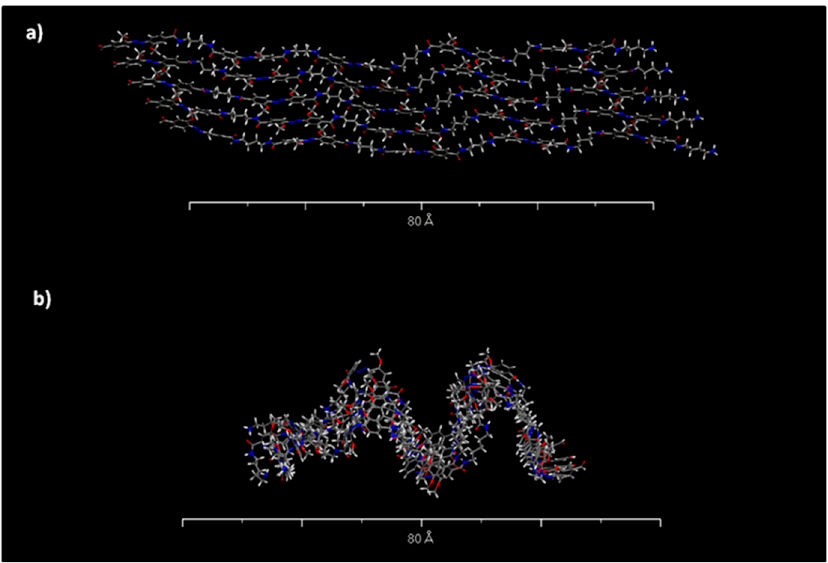
Figure 6. Topographies of polymer chains between neighboring cross-linker molecules, formed by azo and DAB units before ( a ) and after ( b ) irradiation.